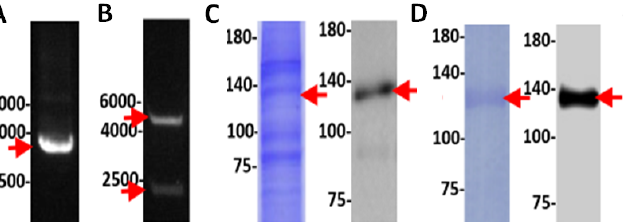
Figure 7. Electrophoresis and staining of biomolecules during the serial steps to clone TVAG_136330 gene and express TVAG_136330 proteins including ( A ) intact plasmids with gene insert, ( B ) digested plasmids showing separated plasmid backbone and gene insert, ( C ) a crude protein sample (left) with antibody staining of TV NOS (right), and ( D ) purified protein sample (left) with antibody staining of TV NOS (right). Note that most impurities in protein were removed after purification.